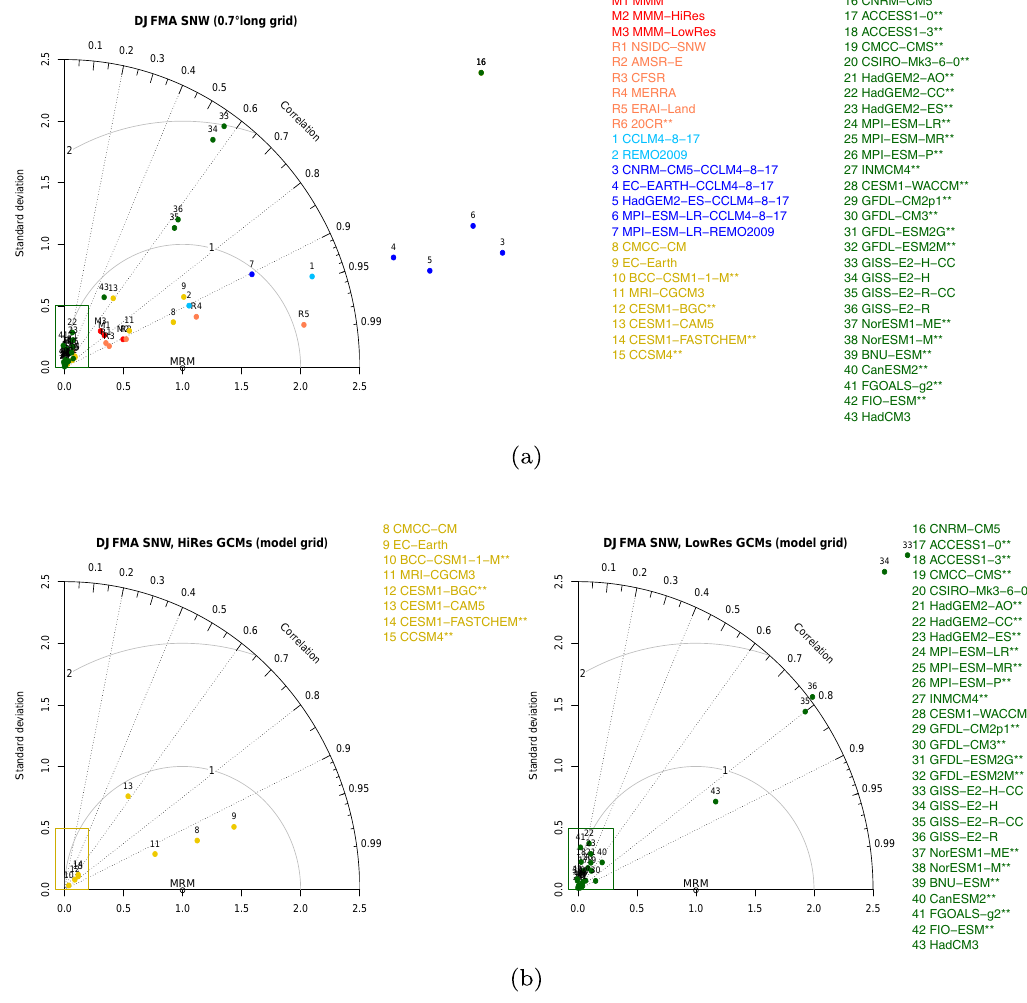
Figure 5. Taylor diagrams of the multiannual mean (1980–2005) of the DJFMA average snow water equivalent as described by climate models against the multi-reference mean (MRM): (a) all data sets are projected onto the same reference grid at 0.7 ◦ lon; (b) the climate models are kept at their original resolution and the reference data sets are remapped onto the grid of each model. Points included in the rectangles correspond to models highlighted with ** in the